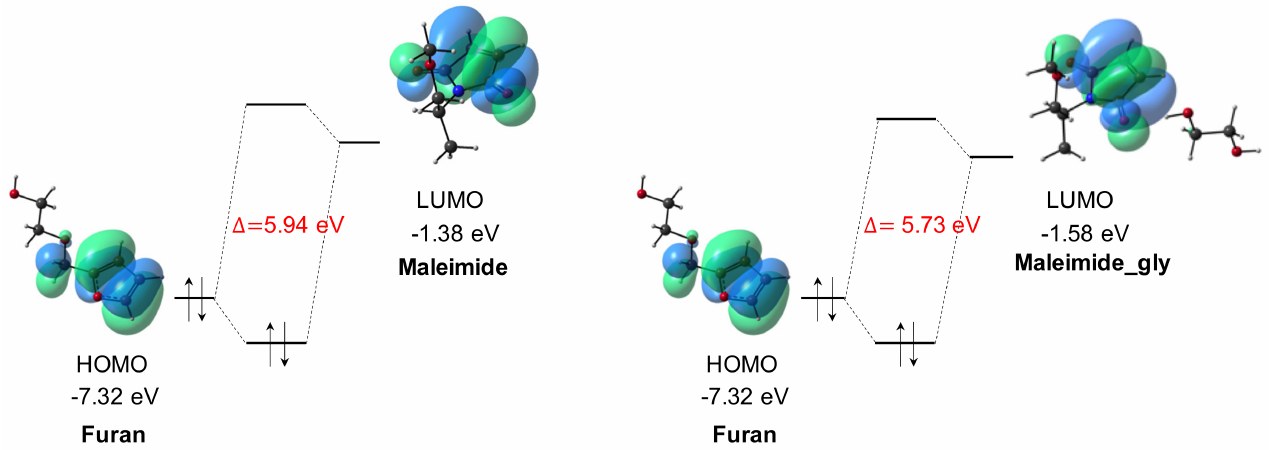
Figure 5. Orbital diagrams for the normal demand Diels–Alder reaction, with and without addition of glycol. Only the reduced orbital energy gap compared to the uncatalyzed DA reaction, combining Furan and Maleimide_gly, is